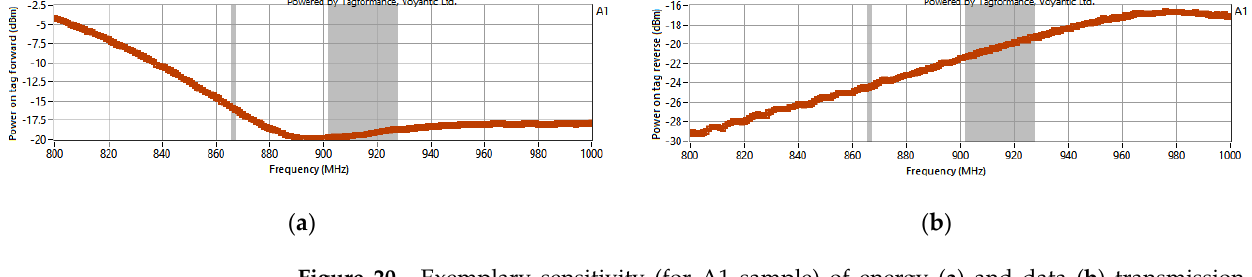
Figure 20. Exemplary sensitivity (for A1 sample) of energy ( a ) and data ( b ) transmission on tag.